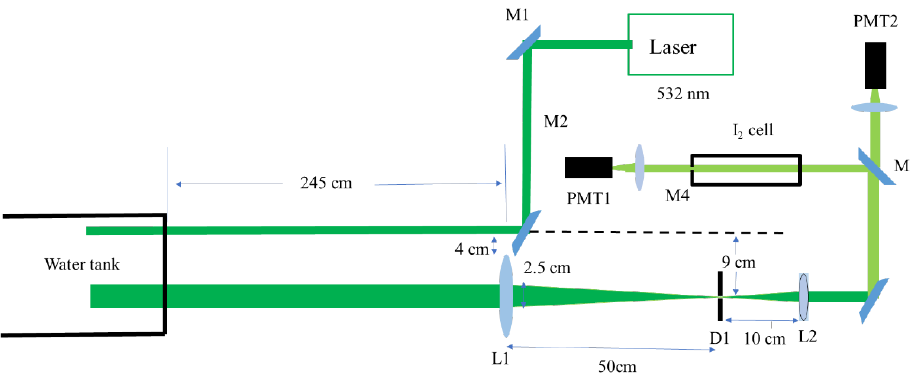
Figure 7. Diagram of the experimental system for Brillouin energy measurement in water.